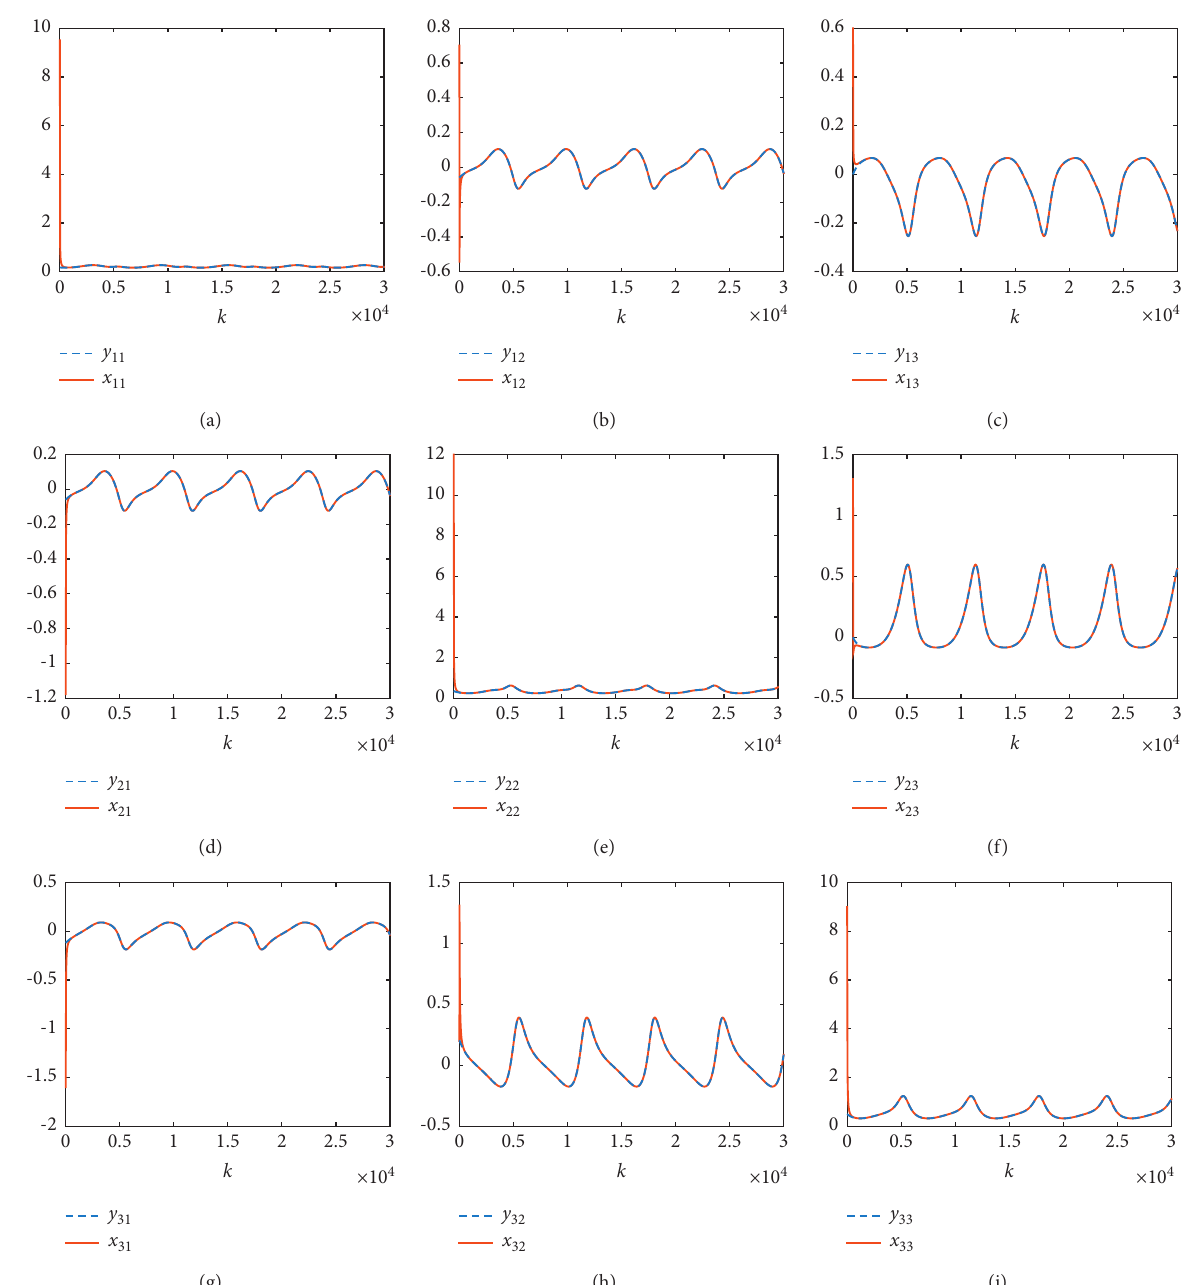
Figure 10: Solution trajectories synthesized by Y c � 5 . 0). (a) Trajectories of y Trajectories of